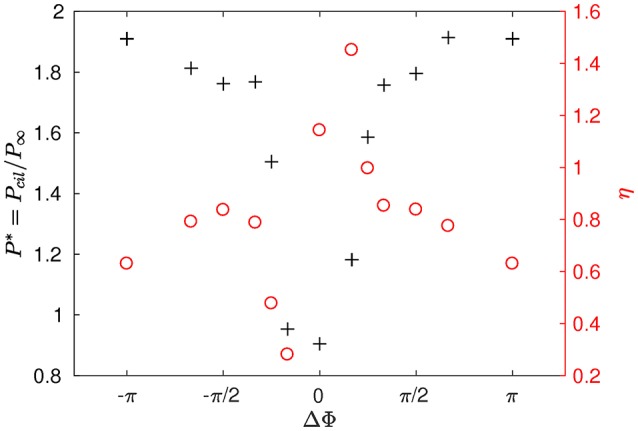
Power P* spent by the system and displacement ratio η obtained for different phase lags ΔΦ and Re = 10−1.